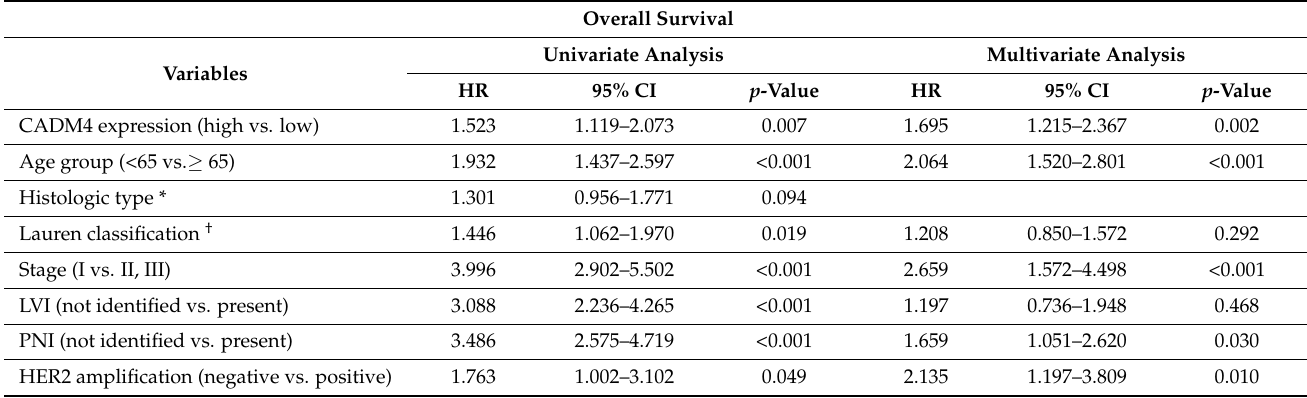
Figure 3. Kaplan–Meier analyses in the HER2-negative group ( a , b ) and the HER2-positive group ( c , d ). Overall survival and recurrence-free survival were significantly worse in patients with low CADM4 expression in the HER2-negative group (Log-rank test, p = 0.003 and p = 0.004, respectively). In the HER2-positive group, there was no significant difference in overall survival or recurrence- free survival according to CADM4 expression.